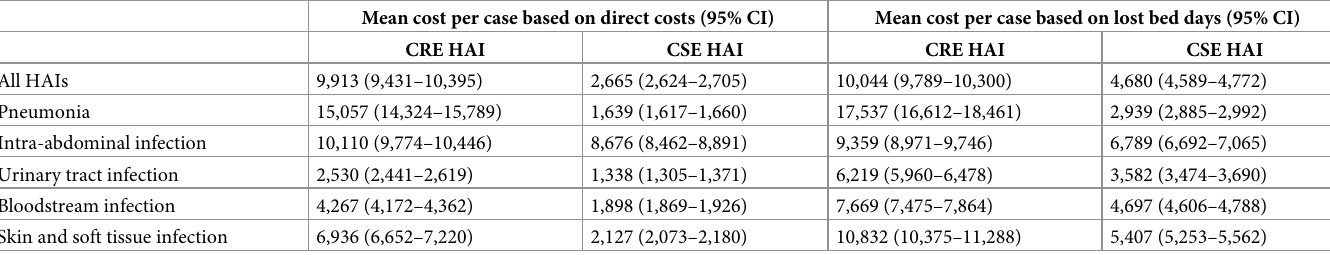
Table 3. Estimated cost of a single CRE-HAI and CSE-HAI based on direct costs and lost bed days. Mean cost per case based on direct costs (95%